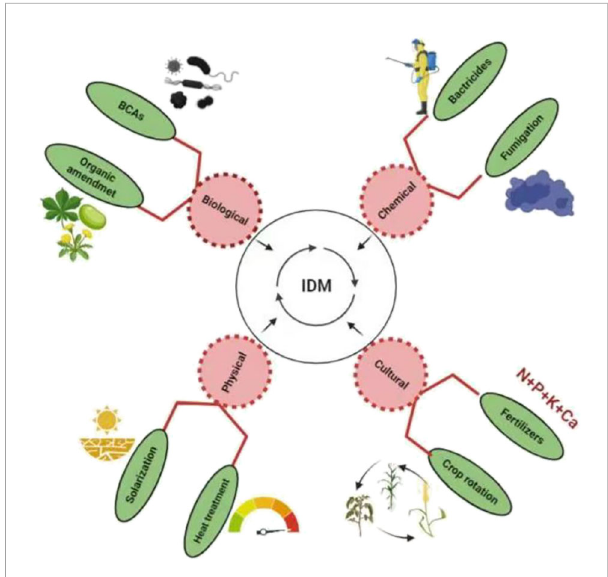
FIGURE 1 Different management strategies used for the management of R. solanacearum